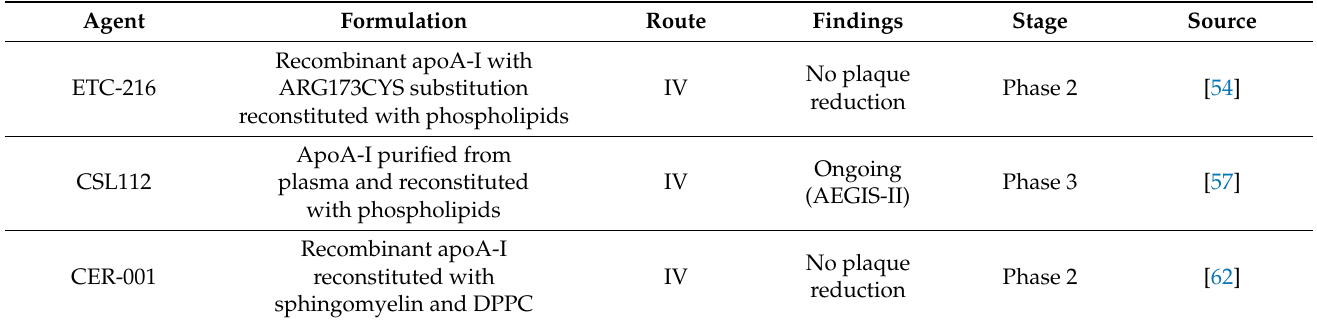
Table 3. Other HDL related